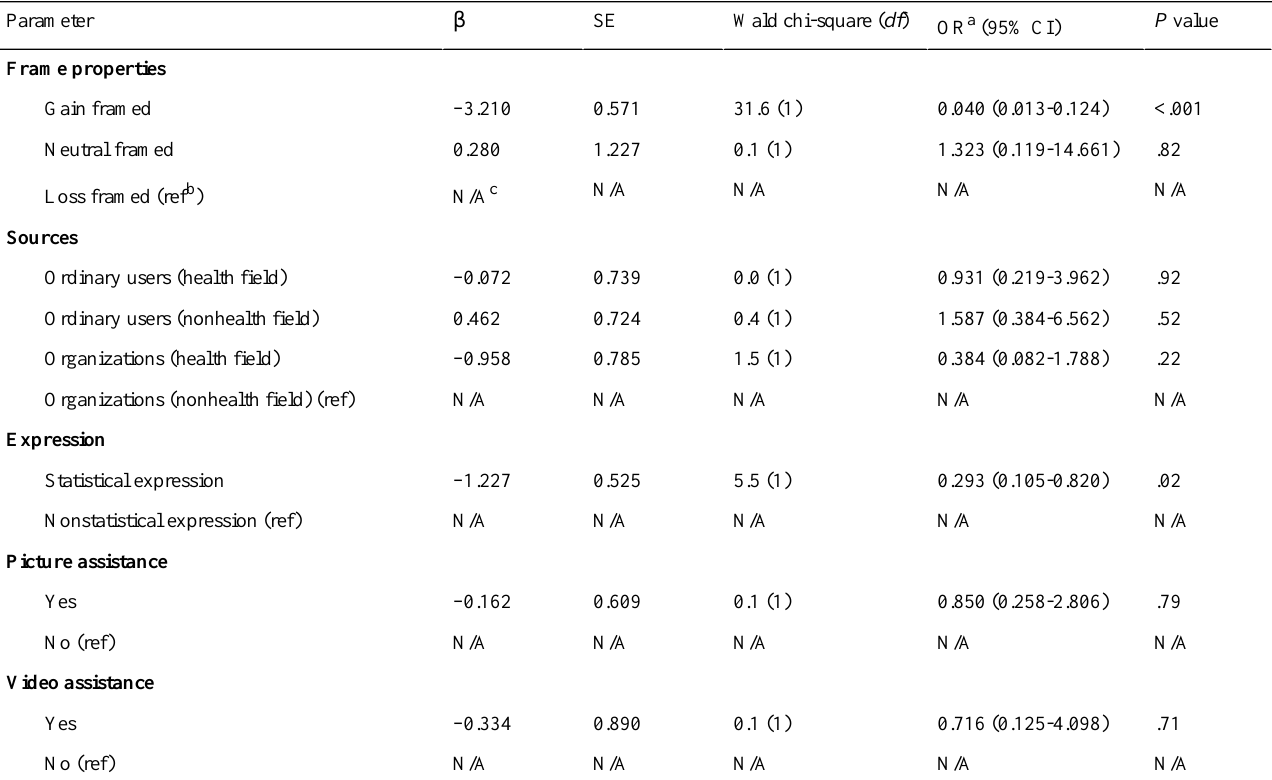
Table 2. Binary logistic regression for health-promoting messages regarding childhood